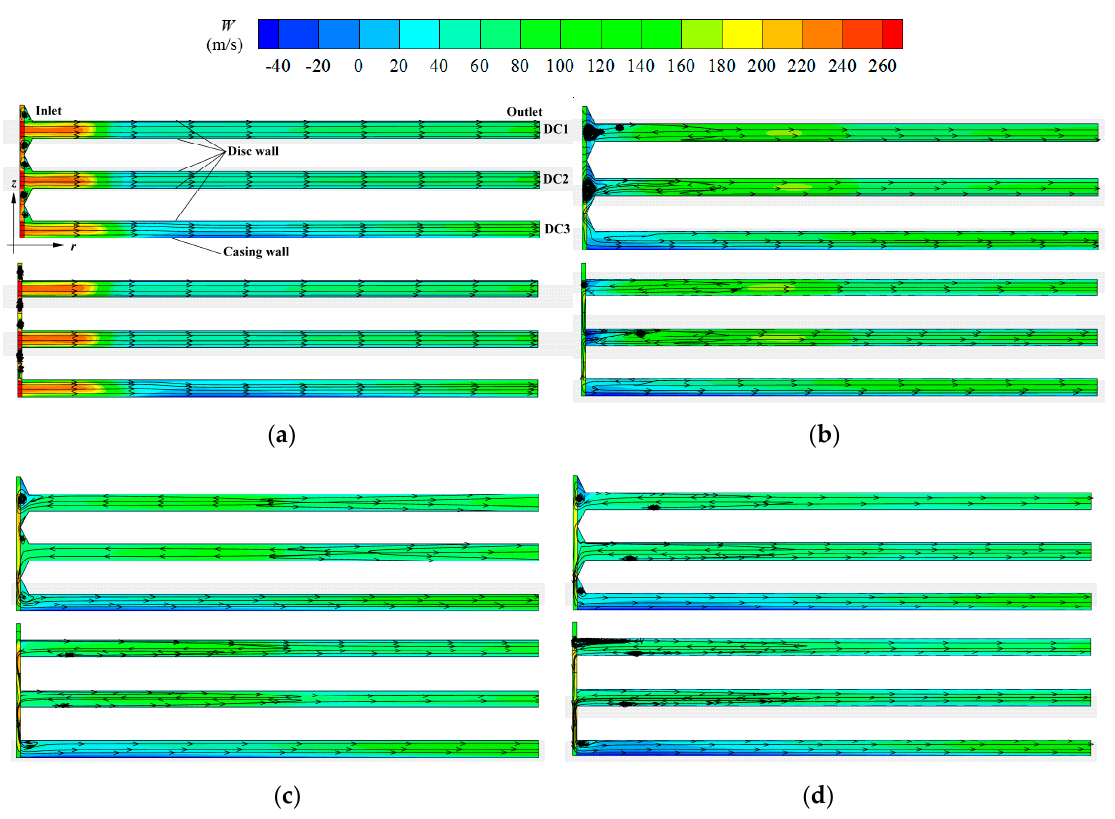
Figure 9. Streamlines and relative tangential velocity distributions on four radial cross-sections of different circumferential angles for OTO-B and OTO-T-2 (in each subfigure the above figure is for OTO-T-2, the below figure is for OTO-B). ( a ) 0°; ( b ) 45°; ( c ) 90°; ( d ) 135°.